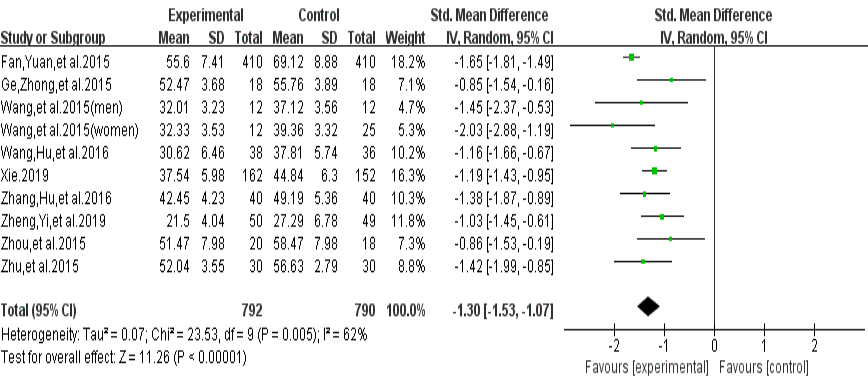
Figure 3. Funnel plot for the publication bias of the total score of smartphone addiction. 3.4.1. Effect of Exercise Interventions on Withdrawal Symptoms The funnel plot of withdrawal symptoms is displayed in Figure 4. Funnel plot showed that the distribution of the included studies was symmetric, and the Begg test result was p = 0.653, indicating